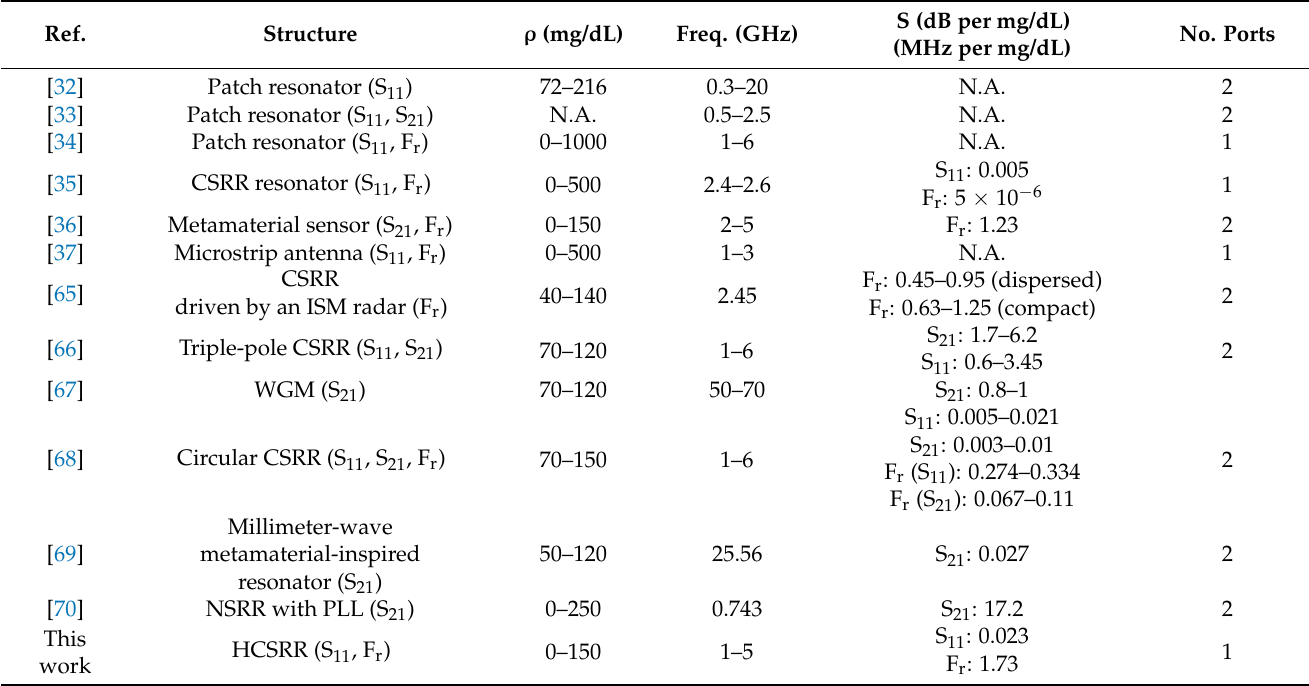
Table 1. The comparison of microwave sensors for glucose level